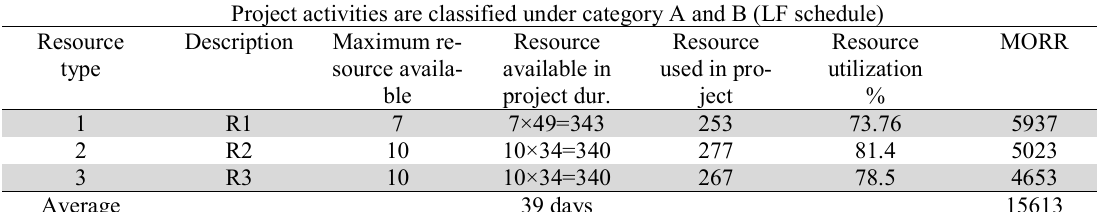
The value of the objective function obtained under LF priority rule for case 2 Project activities are classified under category A and B (LF schedule) Resource